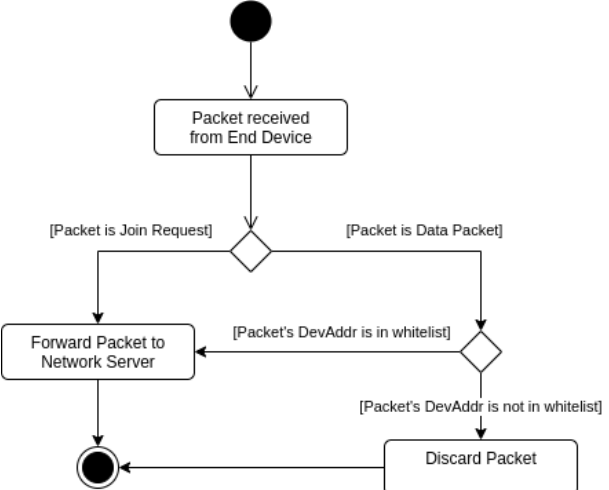
Figure 5. Packet filtering at the gateway